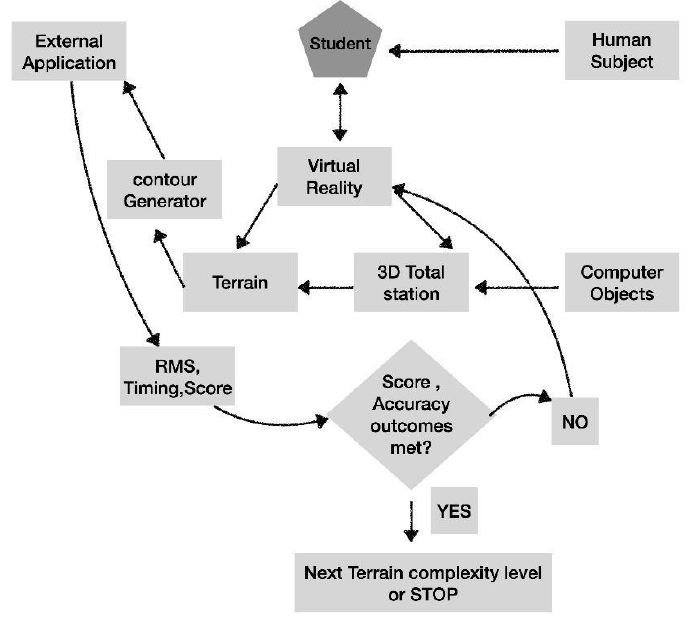
Figure 1. Surveying virtual reality (VR) Cyberlearning workflow diagram.